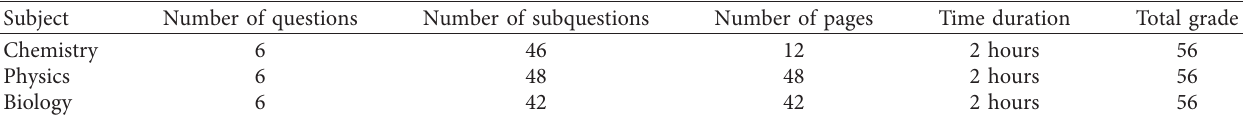
Figure 2: Educational learning Table 1: Description of the final examinations for science (chemistry, physics, and biology).